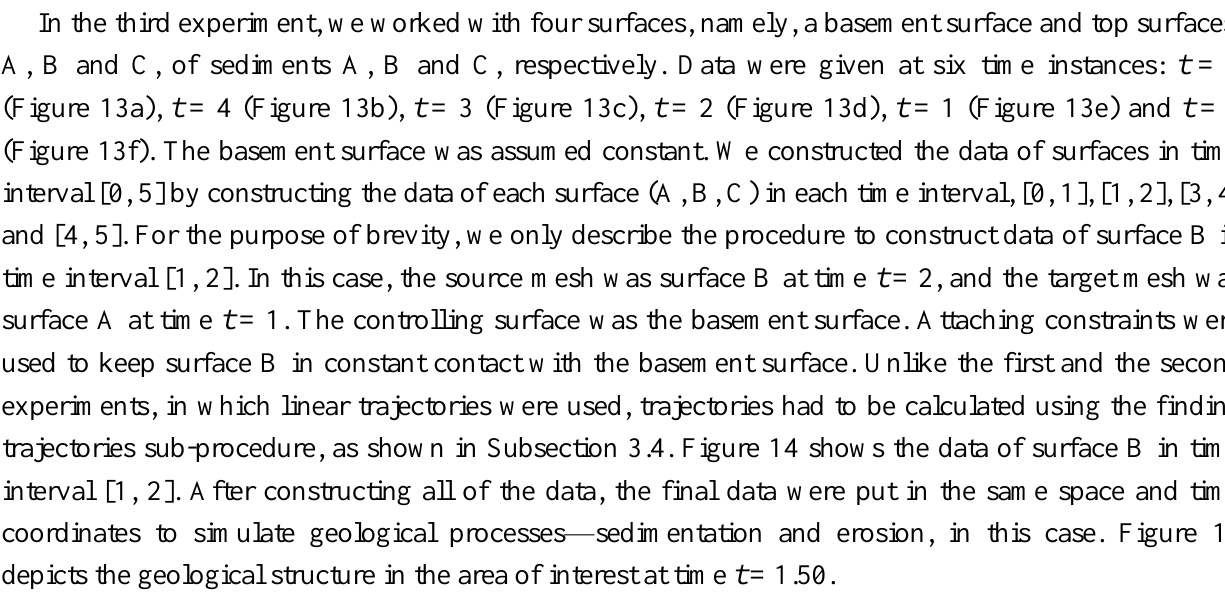
Figure 13. Given data at six time instances. ( a ) t = 5, ( b ) t = 4, ( c ) t = 3, ( d ) t = 2, ( e ) t = 1, ( f ) t = 0.